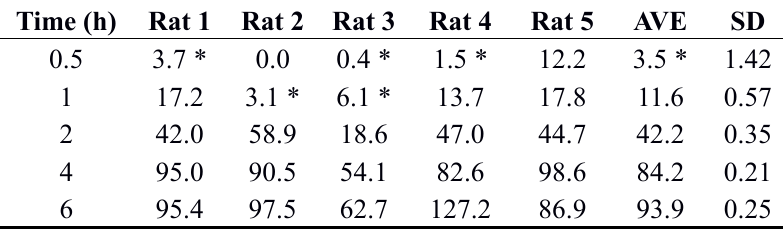
Table 13. Concentration time of TA-III after intragastrical administration to rats at a dose of 25 mg/kg